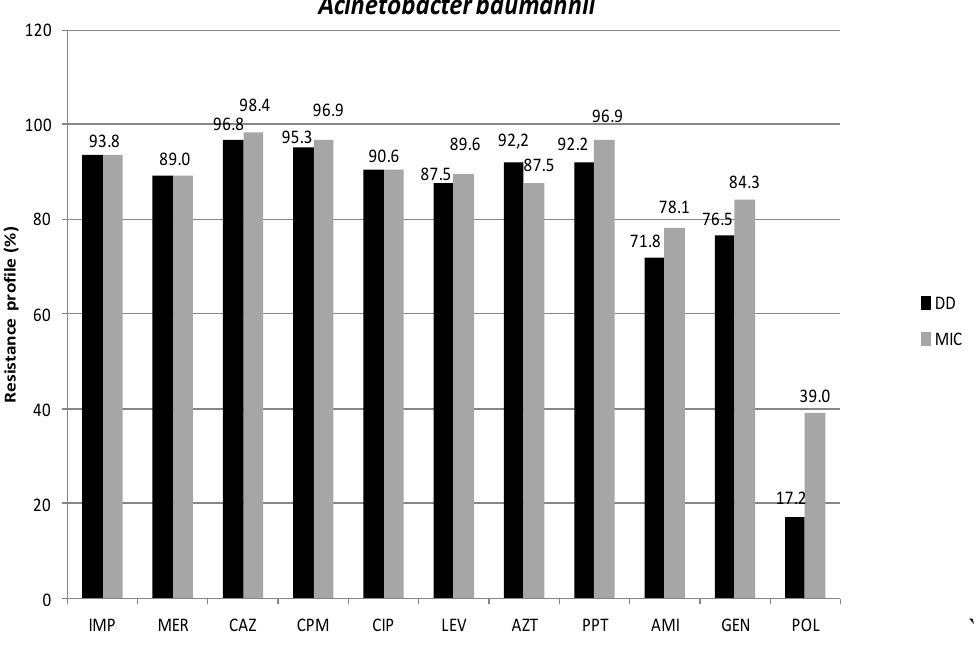
Figure 1. Resistance profiles of 64 A. baumannii strains isolated from blood cultures from patients at five hospitals in this study. IP: Imipenem; MER: Meropenem; CAZ: Ceftazidime; CPM: Cefepime; ATM: Aztreonam; PTZ: Piperacillin/Tazobactam; CIP: Ciprofloxacin; LEV: Levofloxacin; AMI: Amikacin; GEN: Gentamycin; POL: Polymyxin B; DD: disk diffusion; MIC: minimum inhibitory